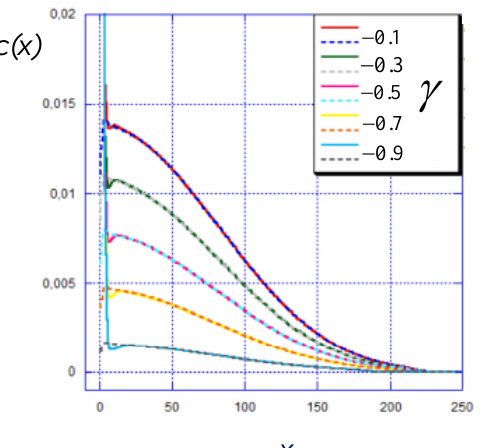
Figure 3. Polymer density profiles in a strong polyelectrolyte brush grafted onto an oppositely charged surface at varied reduced surface charge γ ≤ 0 (as indicated), solid curves, and density profiles in depleted brushes with grafting density 1/ s (cid:48) = ( 1 − | γ | ) / s , dashed lines. Other parameters: N = 300, α = 0.5, a 2 / s = 0.001, salt concentration c s a 3 = 10 − 5 .